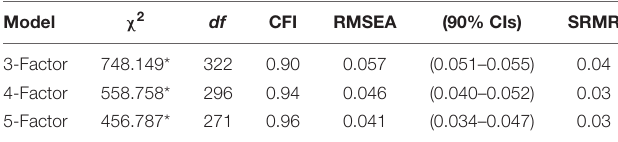
TABLE 3 | Item pattern coefficients for final exploratory structural equation modeling (ESEM) solution.